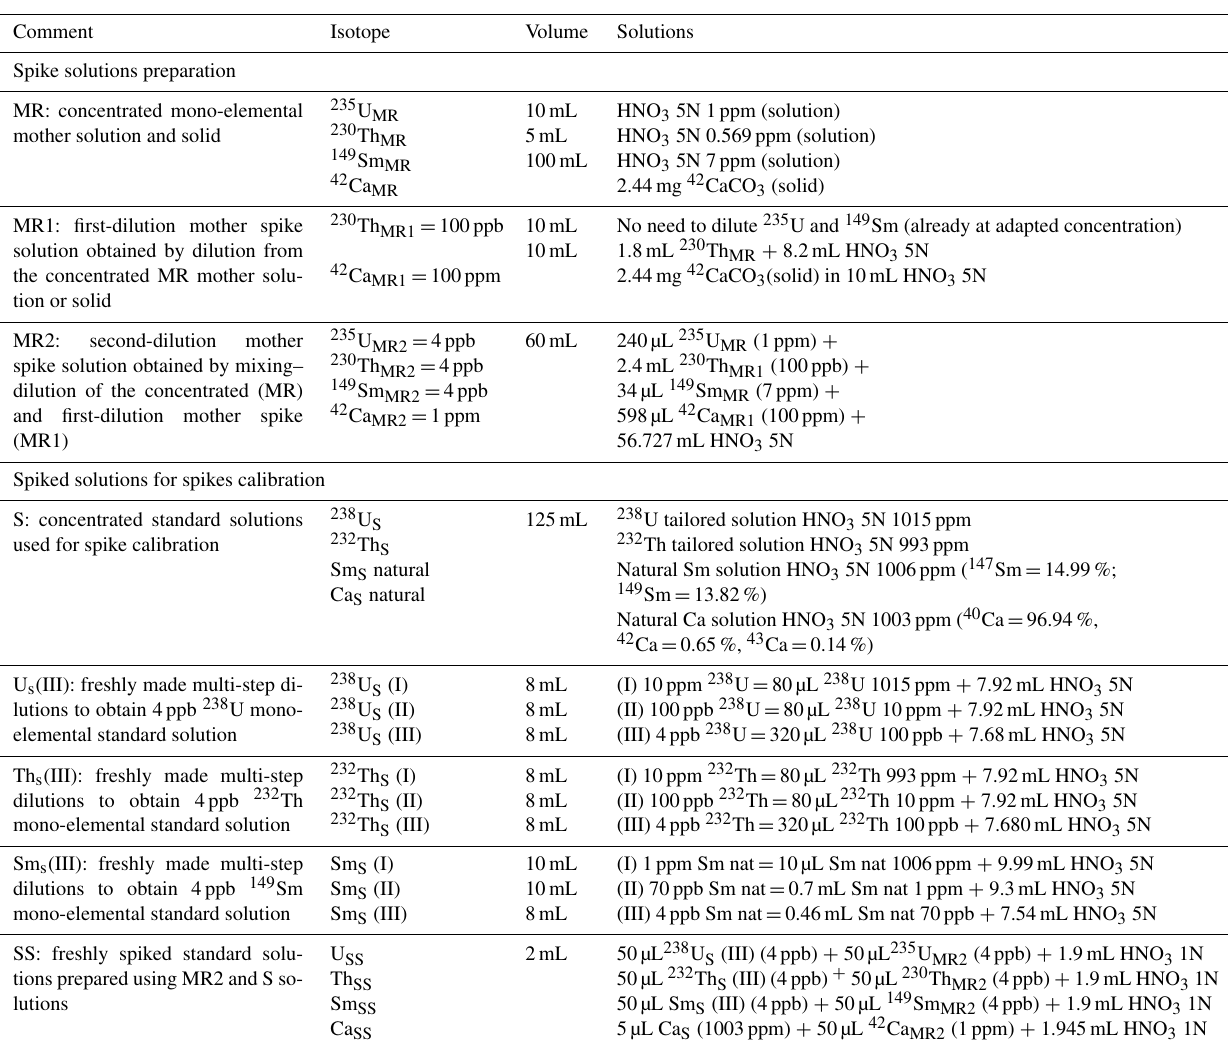
Table A1. U, Th, Sm, and Ca spike calibration table (ppm and ppb: µgg − 1 and ngg − 1